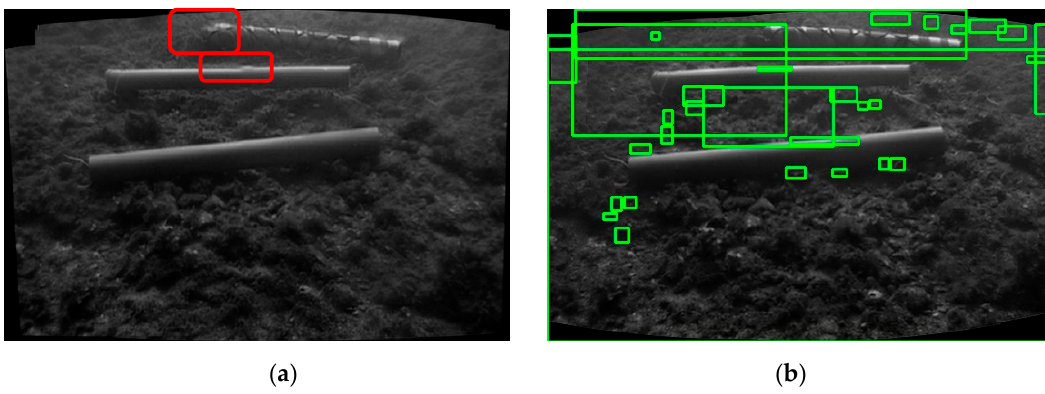
Figure 9. The underwater pipe mosaicked images ( a ) based on SIFT and random sample consensus (RANSAC) with mismatched regions in red and ( b ) compared with proposed model with differences in green.